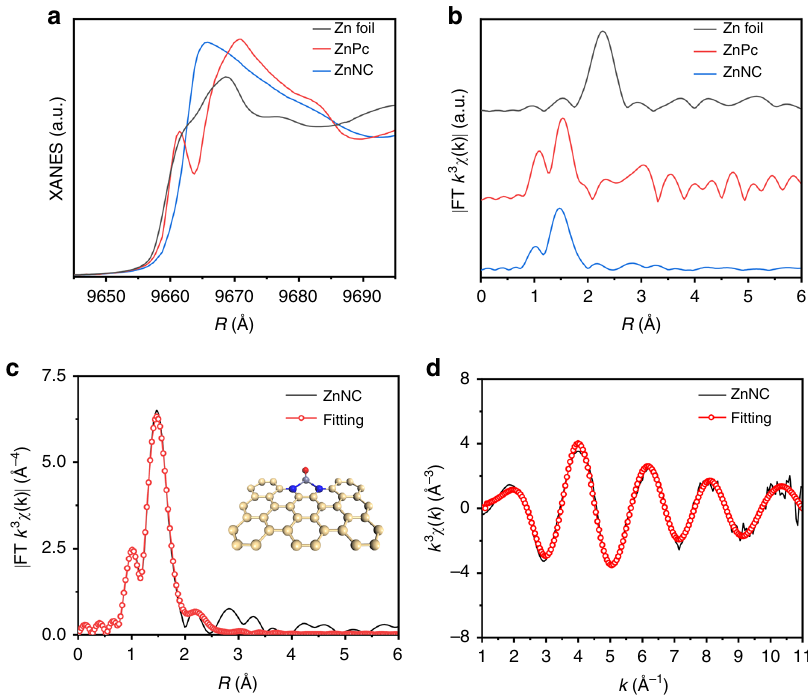
Fig. 2 Structural analysis of ZnNC by X-ray absorption fi ne structure (XAFS) spectroscopy. a Zn K -edge X-ray absorption near edge structure spectra of Zn foil, ZnPc and ZnNC. b Fourier transform (FT) of the Zn K -edge extended XAFS (EXAFS) spectra of Zn foil, ZnPc and ZnNC. c , d Corresponding EXAFS fi tting curve of ZnNC in R and k spaces, respectively. Insets are the schematic model of Zn-N 2 . Light yellow, blue, light purple and red ivory balls represent carbon, nitrogen, zinc and oxygen atoms,